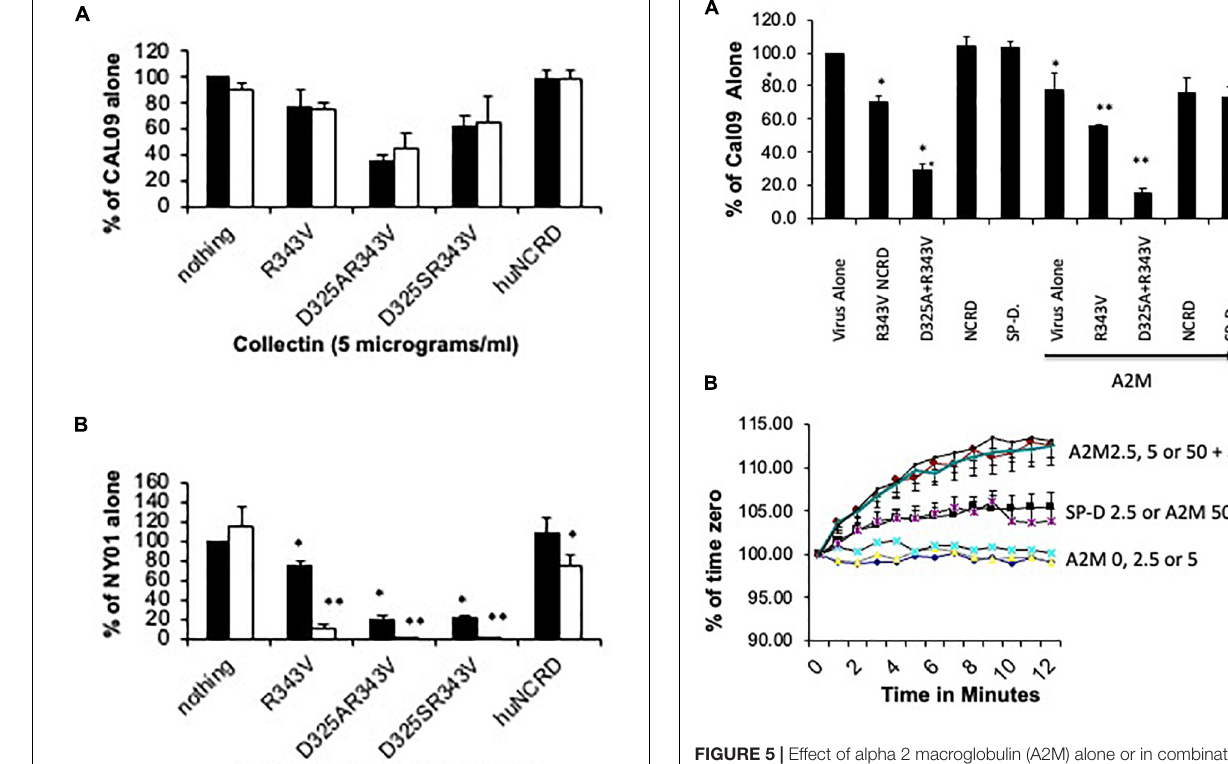
FIGURE 5 | Effect of alpha 2 macroglobulin (A2M) alone or in combination with SP-D proteins on neutralizing activity vs. Cal09 H1N1 or aggregation of Phil82 H3N2. (A) The NCRDs (at 1 µ g/ml) or A2M (at 5 µ g/ml) were added alone or in combination with the Cal09 strain, and neutralizing activity was measured ( ∗ p < 0.05 vs. control and ∗∗ p < 0.05 vs. control or collectin proteins or A2M alone; mean ± SEM; n = 4). (B) The ability of full-length SP-D dodecamers alone (2.5 µ g/ml) and A2M (2.5, 5, or 50 µ g/ml) were added alone or in combination to stirred suspensions of the Phil82 strain to test for viral aggregation. A2M alone at 2.5 or 5 µ g/ml did not cause any viral aggregation, although increasing A2M concentration to 50 µ g/ml did. SP-D caused viral aggregation. Combining SP-D with A2M caused increased aggregation compared with SP-D alone (all combinations p < 0.05 vs. either SP-D or A2M alone; mean ± SEM; n =